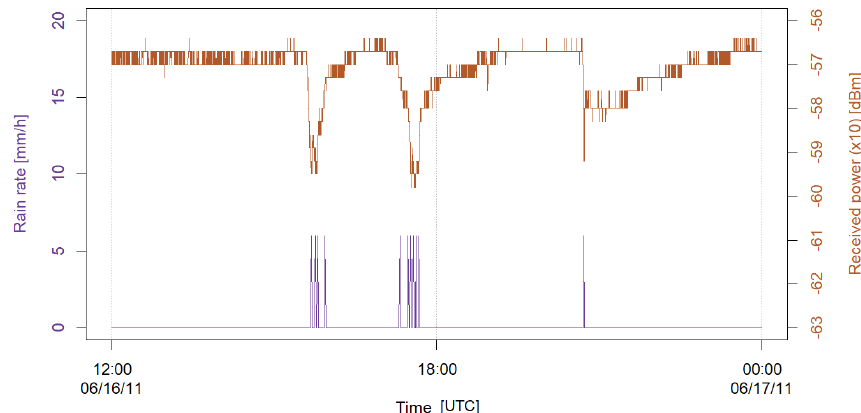
Figure 7. Wet antenna attenuation pattern. Rainfall causes signal resulting in residual wetness on the surface of the radomes. The return of baseline attenuation to previous dry-weather levels is attributed to the drying of the antenna radomes (van Leth et al., 2018). The same behaviour was observed by new E-bands and reported recently in Fencl et al.